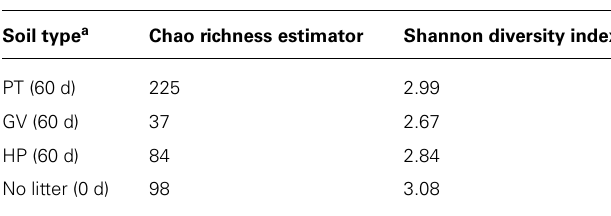
Table 8 | Diversity of fungal communities in microcosms with soil and leaf litter from Populus tremuloides